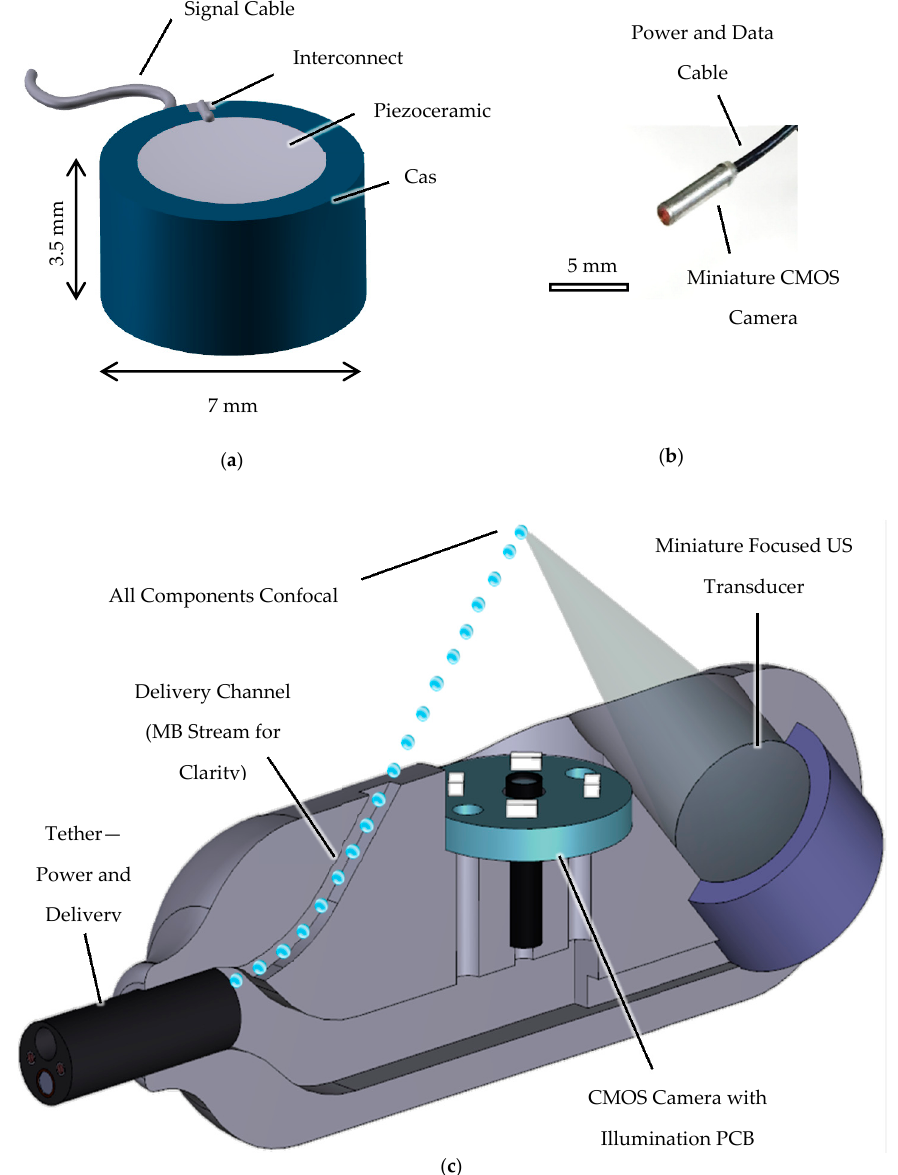
Figure 7. ( a ) CAD cross section of the miniature focused-US transducer with PZ54 bowl, backing layer, interconnects and casing. ( b ) Micro ScoutCam imaging camera 1.2 mm in diameter, 5 mm in length, tethered. Camera passes through illumination board with four LEDs mounted on a PCB with diameter 8 mm. ( c ) CAD cross section of the capsule with components included. All components are confocal and the US beam and therapeutic agents are indicated in the drawing. The capsule has diameter D cap = 10 mm and length L cap = 30 mm.